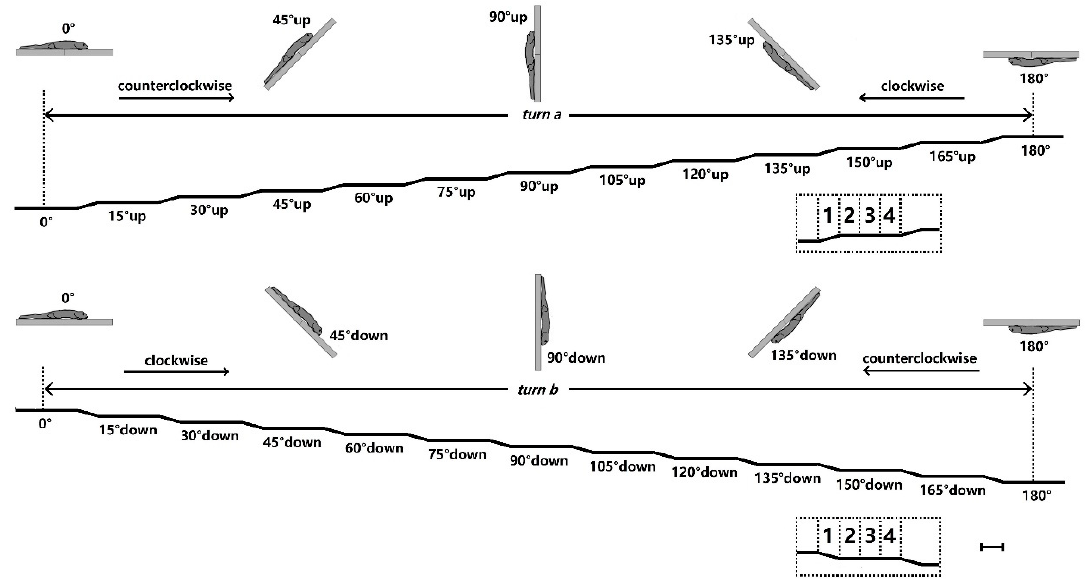
Figure 2. Experimental design for periodic trapezoid tilting. Angle of 0° corresponded to the normal (horizontal) orientation of the gecko with its dorsal side down, and rostral is to the right. Scale bar = 1 s for all. A total of 2 sequential half turns (turn a, nose-up rotations, counterclockwise, and the reverse; turn b, nose-down rotations, clockwise, and the reverse) were performed in 15° steps. Duration of each step was approximately 4 s, as the transition from one position to the next lasted approximately 1 s, and each position was maintained for approximately 3 s (insets).